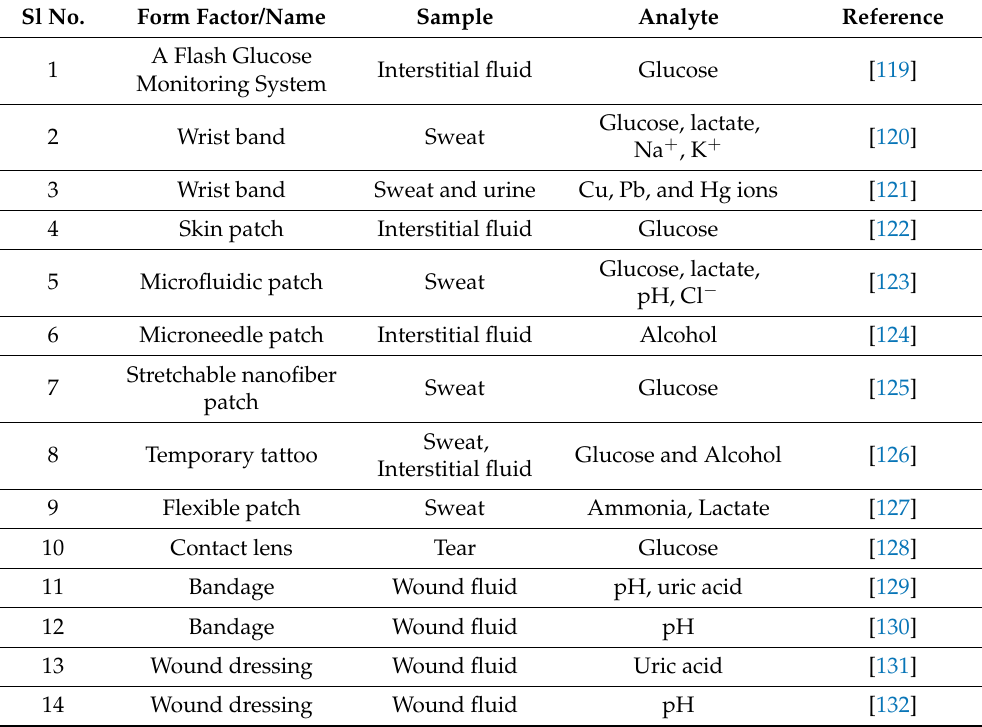
Table 2. List of some of the wearable sensor system for POCT of different biomolecules. Sl No.